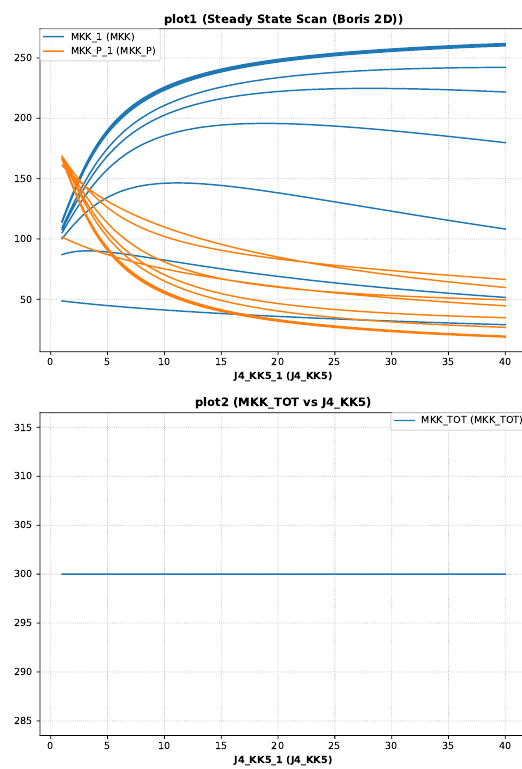
Figure A.12: Simulation with tellurium